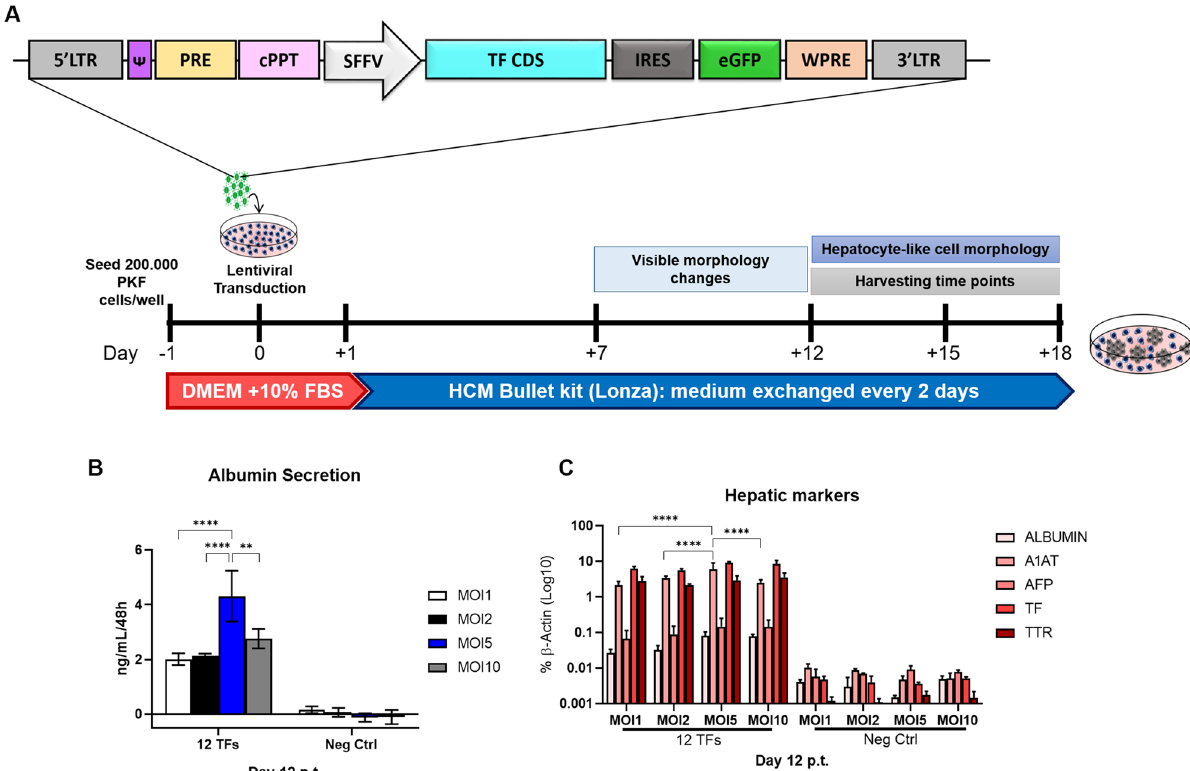
Figure 1. MOI determination for hepatic conversion of PKFs. ( A ) Schematic drawing of lentivirus vector design and cell culture protocol for directed hepatic conversion. ( B ) Albumin secretion quantification and ( C ) hepatic markers expression levels of cells directly reprogrammed with different MOIs per lentiviral vector of all 12 TFs, compared to Neg-Ctrl. All data were analyzed using two-way ANOVA, with Bonferroni’s post-test, except for TF gene, that was converted to mixed effects with Tukey’s multiple comparison post-test due to be missing one value. Significance from n = 3 independent values is displayed as *p < 0.05; ****p ≤